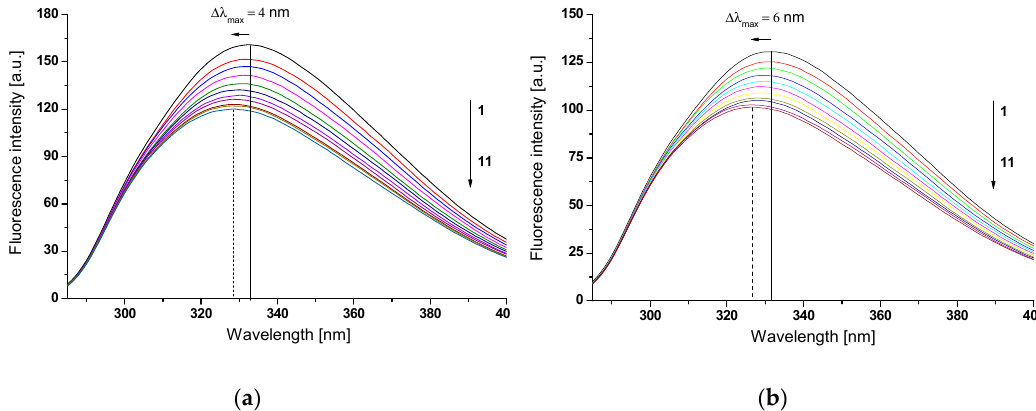
Figure 5. Emission fluorescence spectra of ( a ) HSA and ( b ) gHSA FRC at 2 × 10 − 6 mol ∙ L − 1 (1) concentration in the presence of GLZ at 4 × 10 − 6 mol ∙ L − 1 (2)–40 × 10 − 6 mol ∙ L − 1 (11) concentrations, λ ex = 275 nm; the arrows indicate the shift direction of the maximum fluorescence of HSA and gHSA FRC ( Δλ max ) with the increase of GLZ concentration; t = 37 °C.